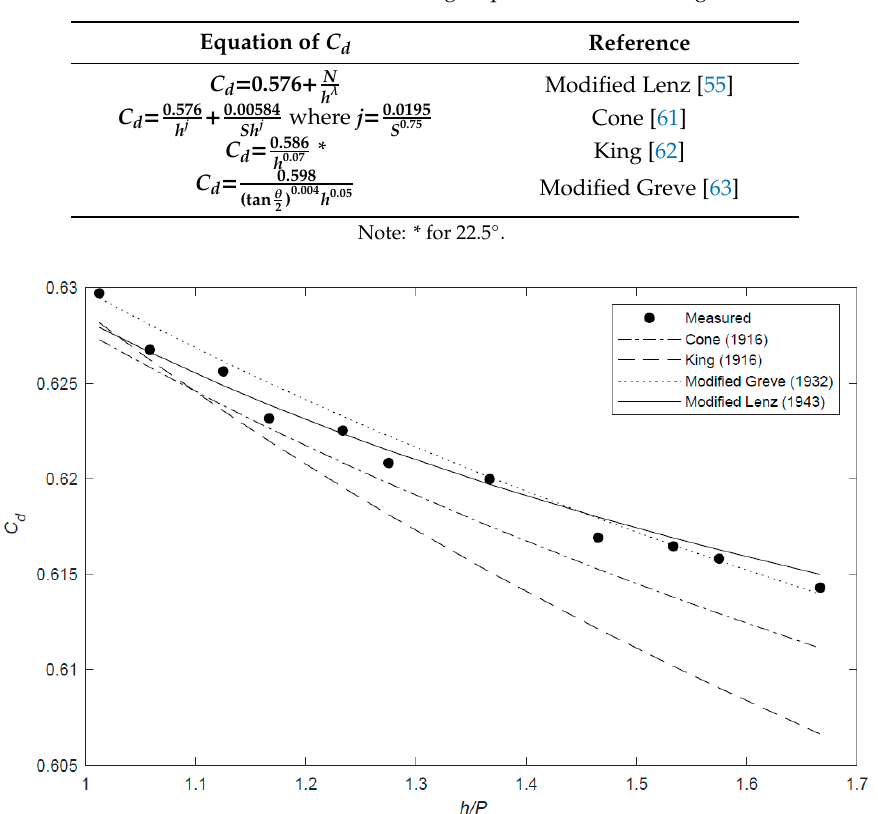
Table 4. Modified coe ffi cient of discharge equations for 30 ◦ triangular weirs.